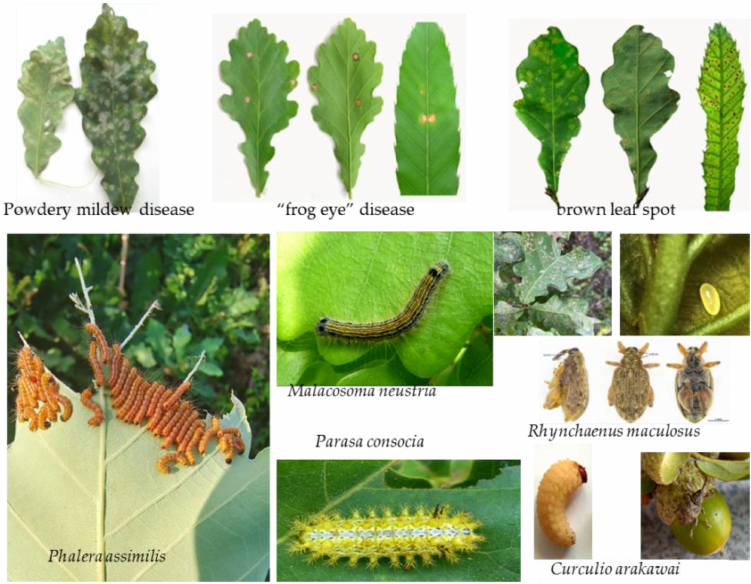
Figure 3. Partial leaf diseases and oak tree